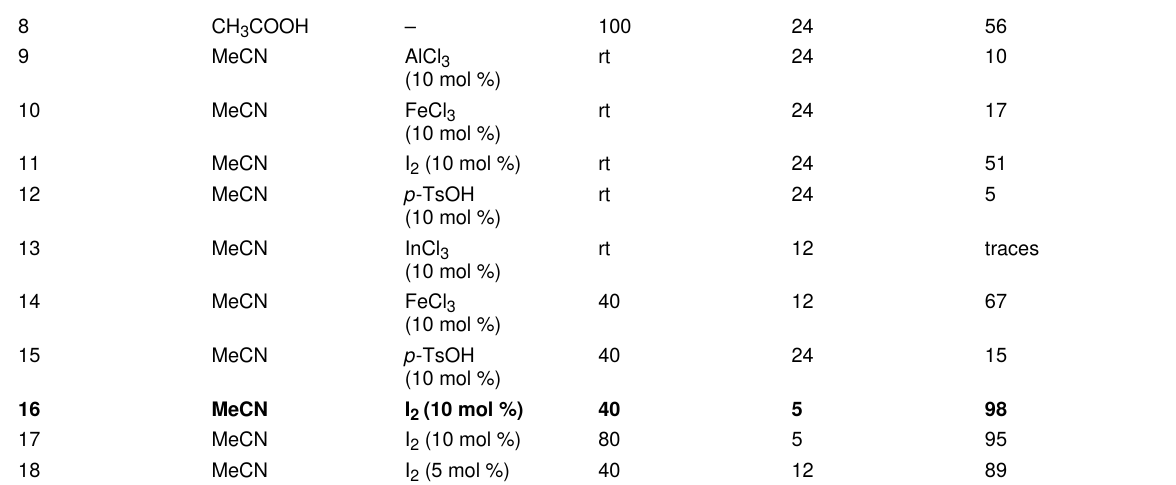
room temperature. Among these, the presence of I 2 led to the highest yield of 51% (Table 1, entry 11). This trend was consis- tent: Upon heating to 40 °C, reactions with FeCl 3 (Table 1, entry 14) or p -TsOH (entry 15) yielded 67% and 15% of prod- uct, respectively, while 98% of the product was obtained in the presence of I 2 (Table 1, entry 16). However, further increase of the reaction temperature to 80 °C did not significantly affect the generation of the product (Table 1, entry 17). Lowering the amount of catalyst from 10 mol % to 5 mol % reduced the prod- uct formation (Table 1, entry